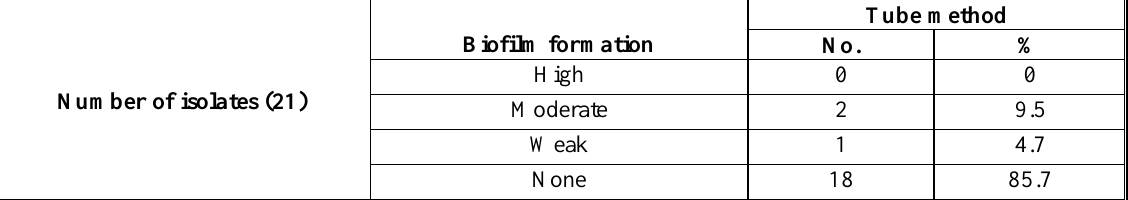
Table 5. Number and percentage of the isolates that formation biofilm by tube method .